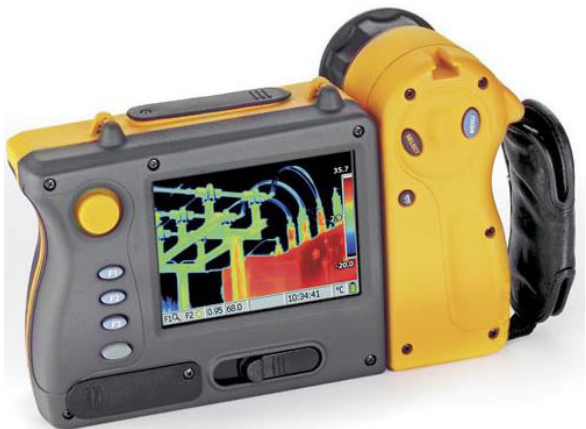
Figure 17. Thermal imaging thermometer.